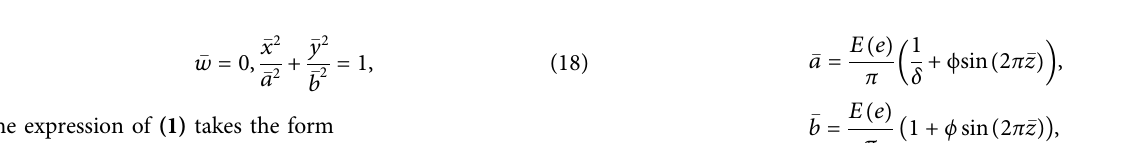
Frontiers in Physics |